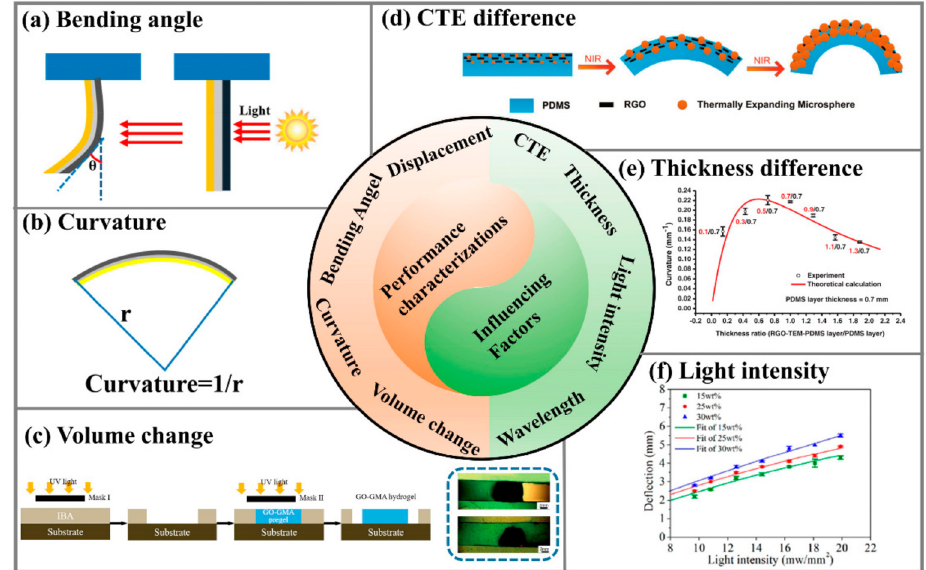
Figure 8. ( a , b ) Analysis method of bending angle and curvature. ( c ) Schematic diagram of light- responsive behavior of GO − GMA hydrogel within a microfluidic channel; images were taken under a microscope [88]. Permission from Royal Society of Chemistry. ( d ) The bending mechanism of the bi-layer actuator is caused by the difference in thermal expansion coefficient. ( e ) Curvature changes are caused by differences in thickness [38]. ( f ) Changes in bending displacement are caused by light intensity [39]. Permission from American Chemical